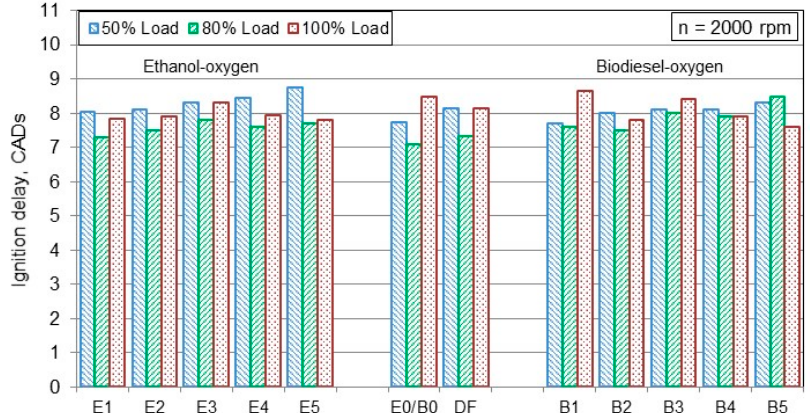
Figure 4. The ignition delay as a function of ethanol–oxygen or biodiesel–oxygen mass content (wt%) in fuel blends for a turbocharged CRDI engine running under medium (50%), intermediate (80%), and full (100%) loads corresponding to the respective IMEPs of 0.75, 1.20, and 1.50 MPa developed at maximum torque speed of 2000 rpm.